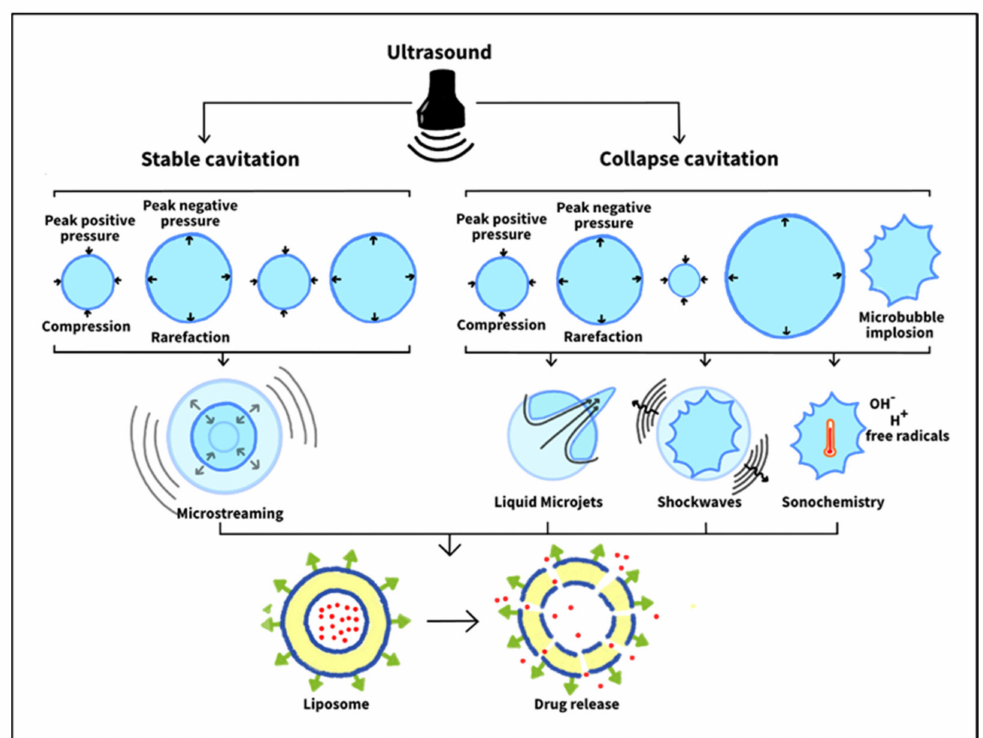
Figure 5. Ultrasound-induced mechanical effects include cavitation, which can be either stable or collapse. In stable cavitation, the microbubble oscillates about an equilibrium size, resulting in microstreaming in the surrounding liquid. On the contrary, in collapse cavitation, the microbubble exceeds its equilibrium size and expands until it implodes. This, in turn, leads to three distinct outcomes: (1) liquid microjets formation, (2) shockwaves, and (3) sonochemistry. All these together can destabilize the liposomal lipid bilayer, releasing the encapsulated